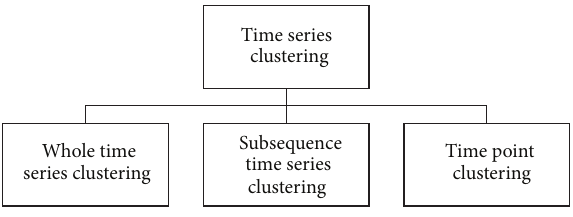
Figure 3: Time series clustering